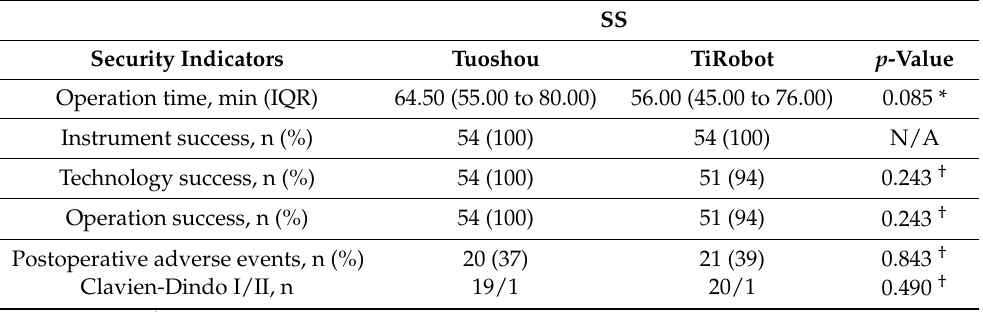
Table 5. Differences between two groups in security indicators.